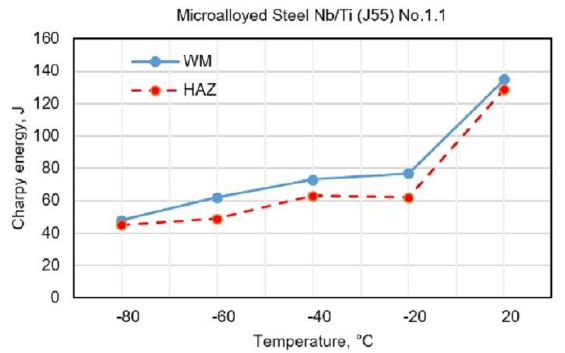
Figure 3. Test results of impact energy at test temperatures of welded joints made with electrode No.1.1.